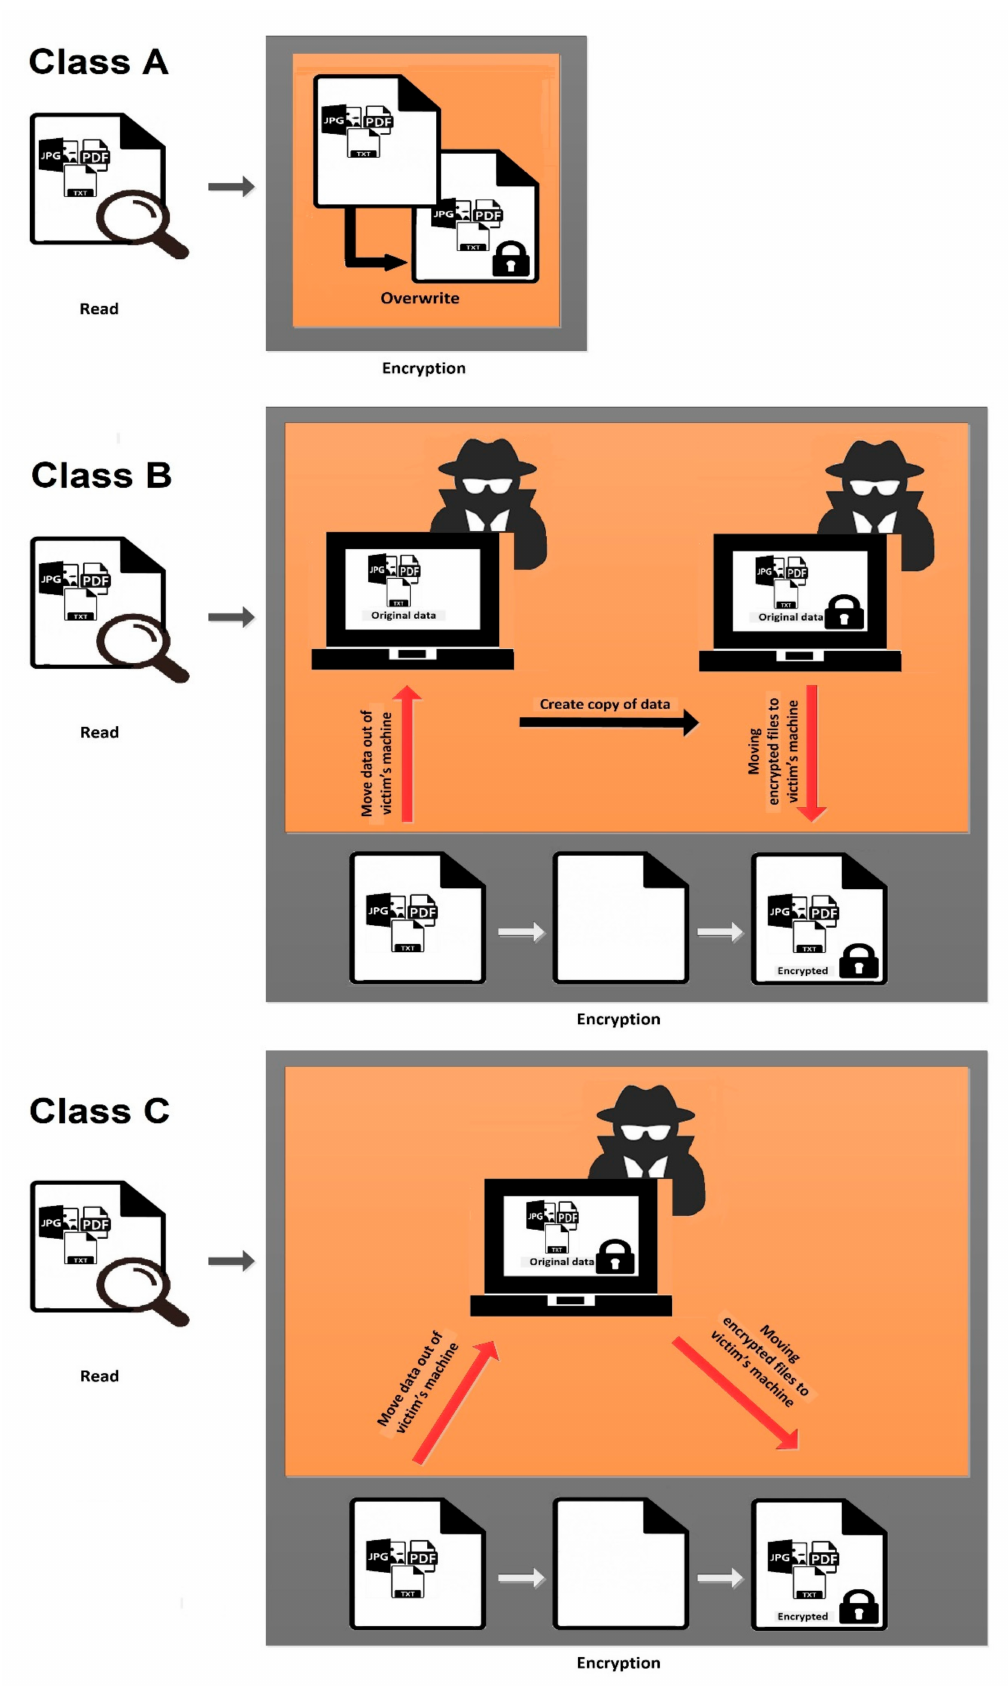
Figure 3. Ransomware attack